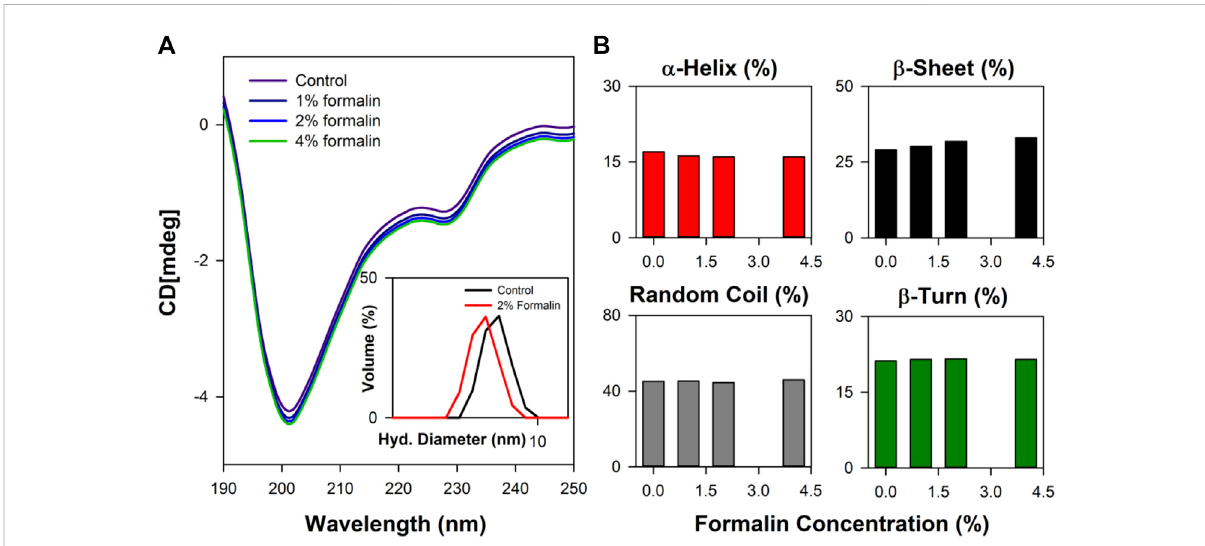
FIGURE 3 Far UV CD spectroscopy study of CHT. (A) The far UV CD spectra representing structural integrity of formalin treated CHT. The inset shows the DLS spectra of CHT at representative formalin concentration. (B) Percentage composition of secondary structure shown as bar plots. Analysis of secondary structure indicated structural stability within the experimental setup.